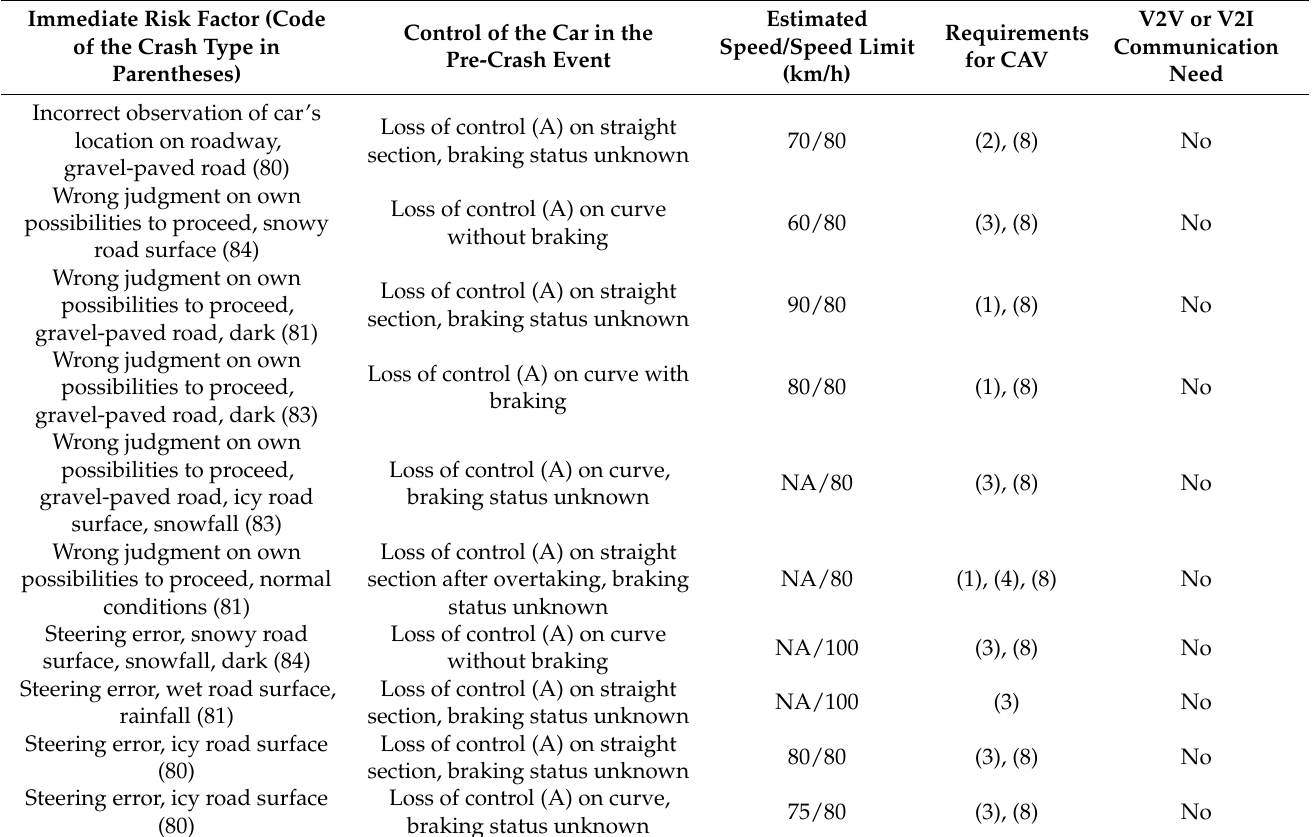
Table 2. Characteristics of the 18 studied single-car